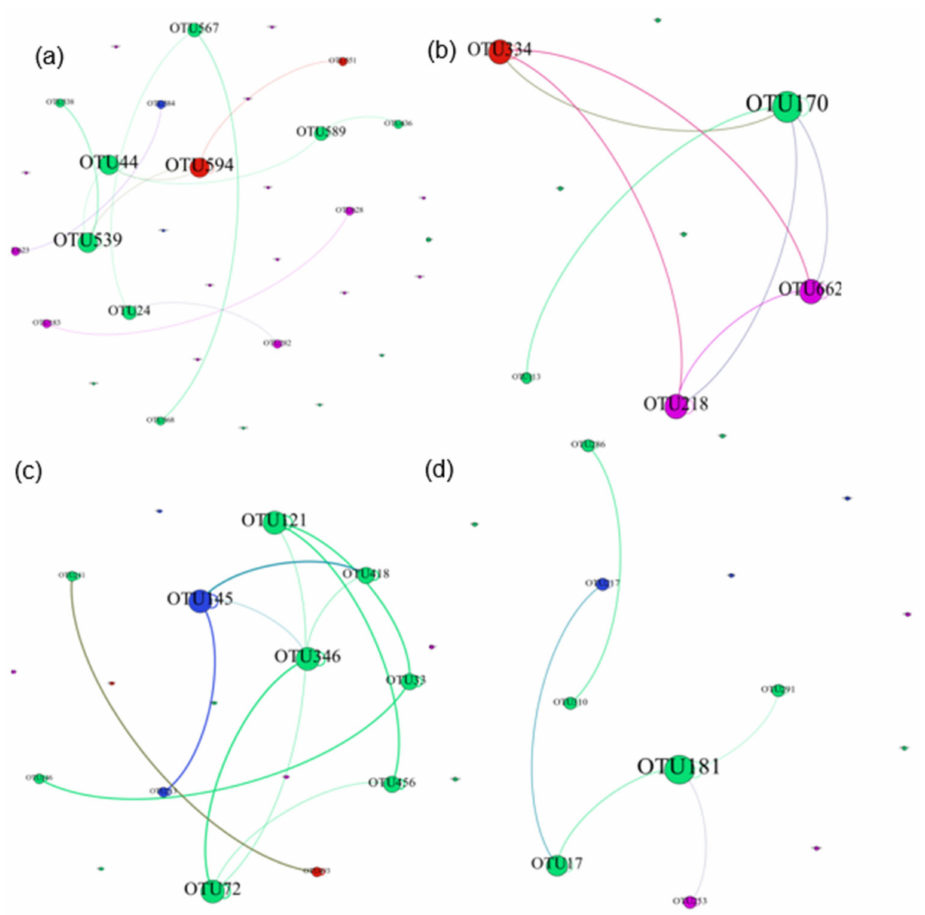
Figure 5. Seasonal collinear network of diatoms in Danjiangkou Reservoir (( a ) is spring, ( b ) is summer, ( c ) is autumn, and ( d ) is